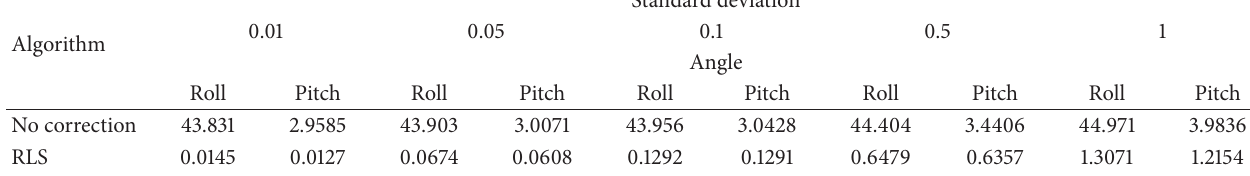
Table 3: Comparison of the convergent values for different standard deviations.